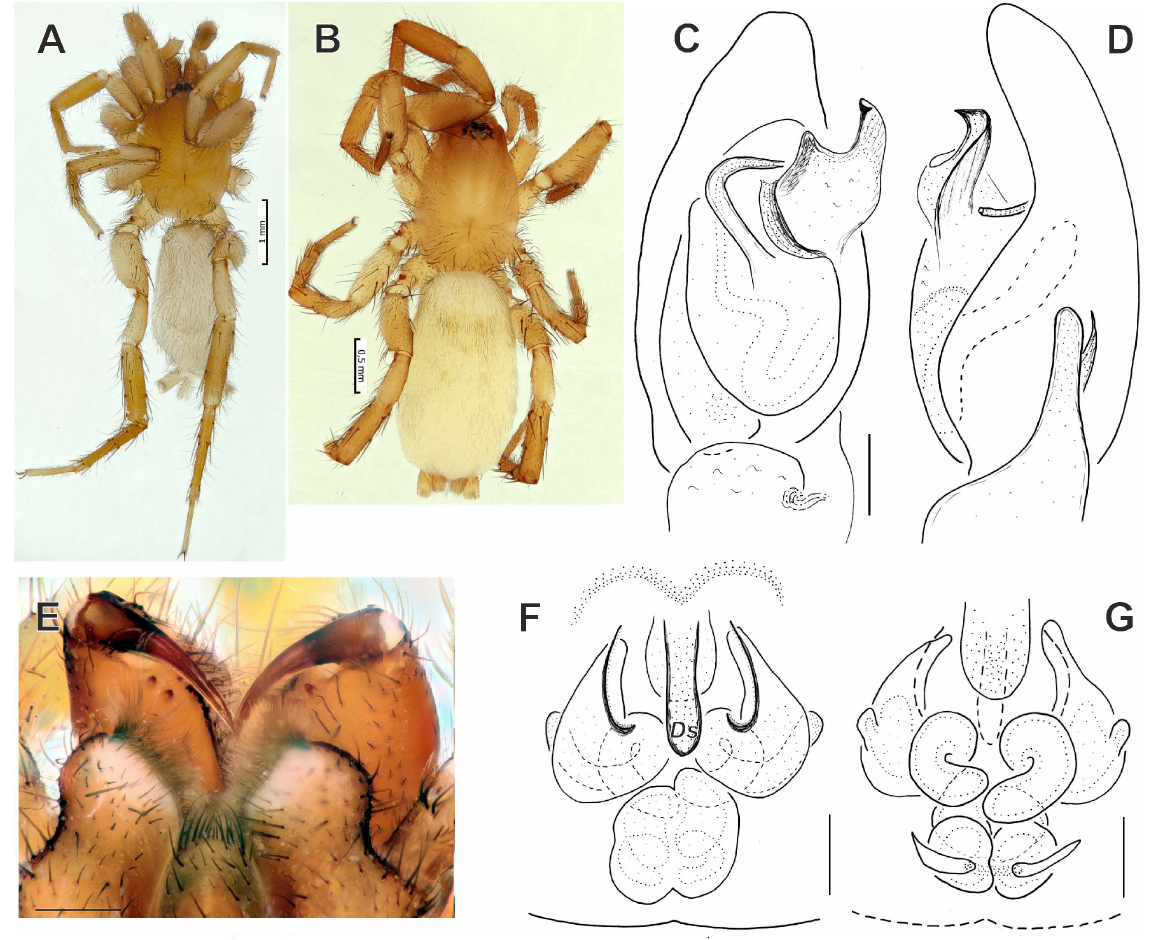
Fig. 24. Zagrotes apophysalis sp. nov. (A, C–E = holotype, ♂, MHNG; B, F–G = paratype, ♀ from Kohgiluyeh & Boyer-Ahmad Province, MHNG). A–B . Habitus, dorsal view. C–D . Palp, ventral and retrolateral views. E . Chelicerae, posterior view. F–G . Epigyne, ventral and dorsal views. Abbreviation: Ds = digitiform scape. Scale bars: A = 1 mm; B = 0.5 mm; C–D, F–G = 0.1 mm; E = 0.2